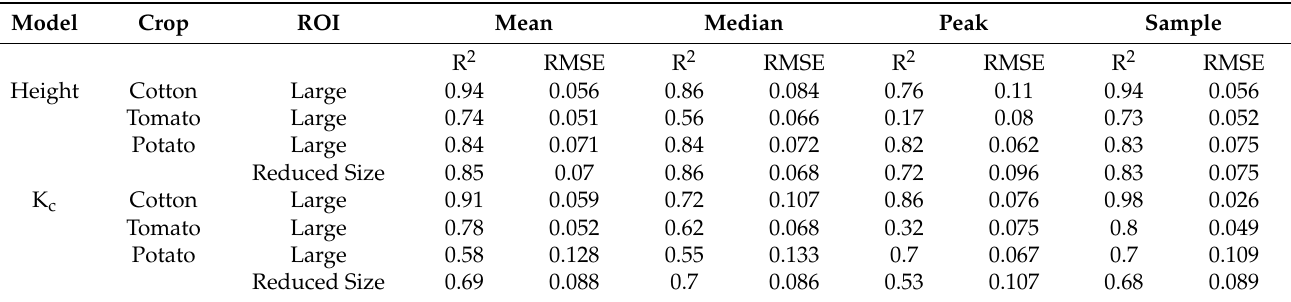
Figure 9. Linear regressions between the crop height models (CHMs) and manual height measure- ments or the crop coefficient (K c ) for the ROIs with reduced size. Table 2. Comparison of fit and error of the different models.